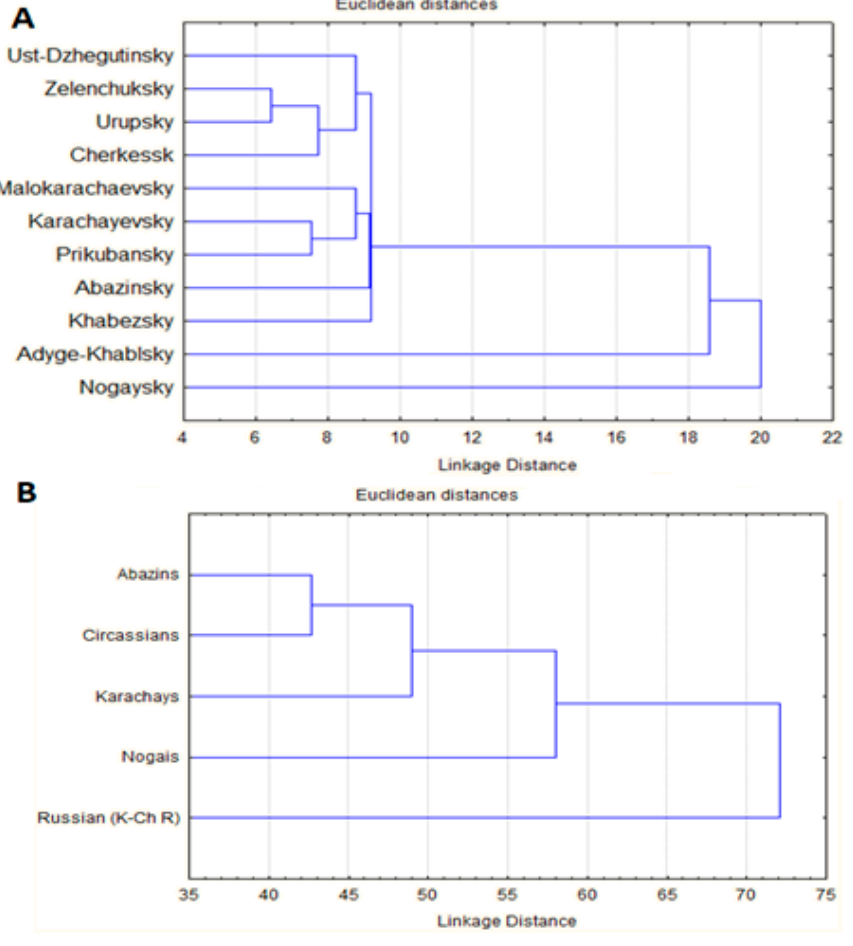
Figure 1. The genetic relationship between different districts of KChR ( A ) and between different populations / ethnic groups of Russia ( B ) by autosomal dominant (AD) and autosomal recessive (AR) diseases.